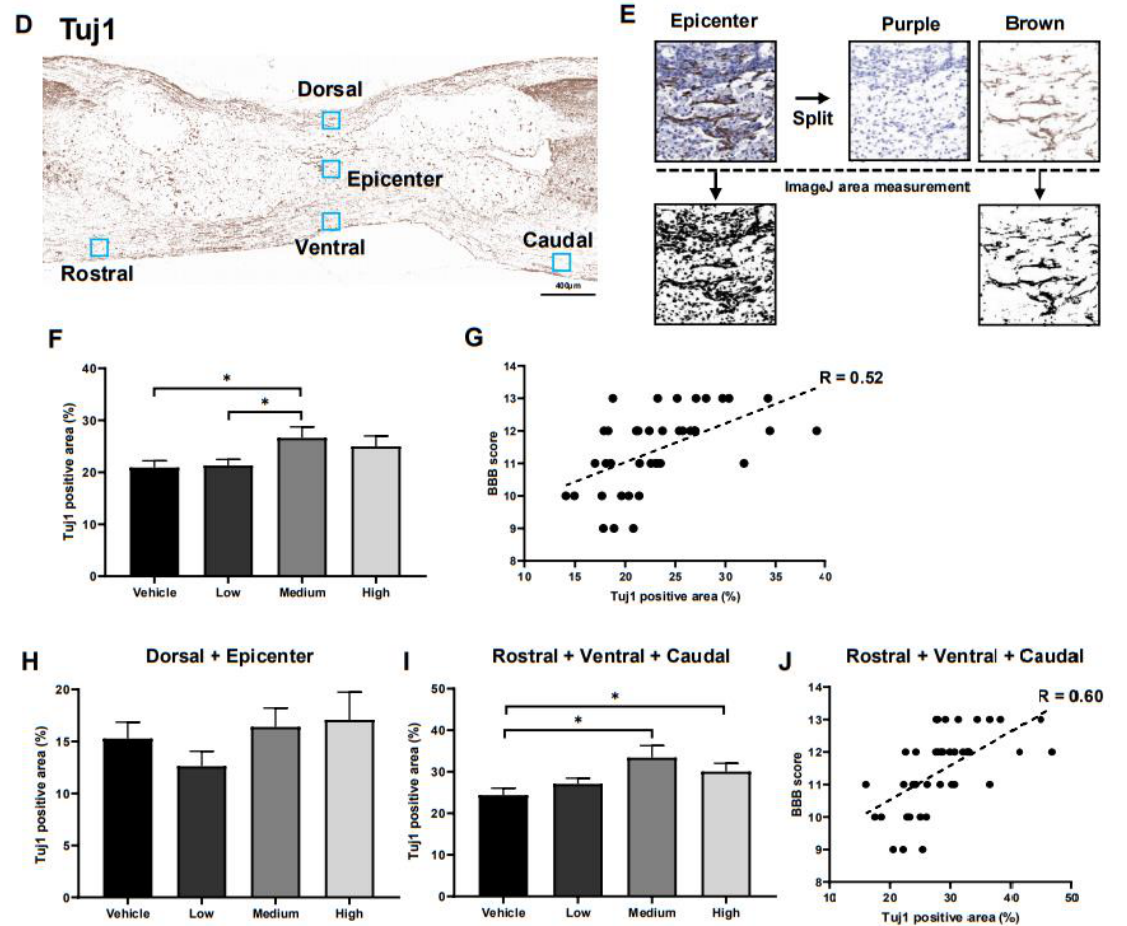
Figure 4. In vivo neuroprotective activities of ahMNCs. ( A ) Immunohistochemistry against NeuN. Red arrows indicate NeuN positive neurons in close proximity to the damaged lesions both rostrally and caudally and the distance between these neurons was evaluated as part of this experiment. Scale bar = 400 µ m and 40 µ m in the lower and higher magnifications, respectively. ( B ) These distances were quantified and then compared. ( C ) Correlation analysis revealed a significant negative relationship between the distance between the NeuN positive cells and the BBB score. ( D ) Tuj1 immunoreactivity was evaluated in five areas: Dorsal, Epicenter, Rostral, Ventral, and Caudal. (E) Imaging revealed which of these areas were experiencing this immunoreactivity. ( F ) The relative intensity of these images was compared to determine the extent of Tuj1 immunoreactivity in each area. ( G ) Correlation analysis revealed a significant positive relationship between the relative area of Tuj1 reactivity and the BBB score. ( H , I ) These immunoreactive areas were independently quantified for the Dorsal and Epicenter lesions ( H ) and Rostral, Ventral, and Caudal lesions ( I ) and then compared. ( J ) Correlation analysis revealed a significant positive relationship between the Tuj1-positive area in the Rostral, Ventral, and Caudal lesions and the BBB score. Height = Average, Error bar = Standard Error. *, P <